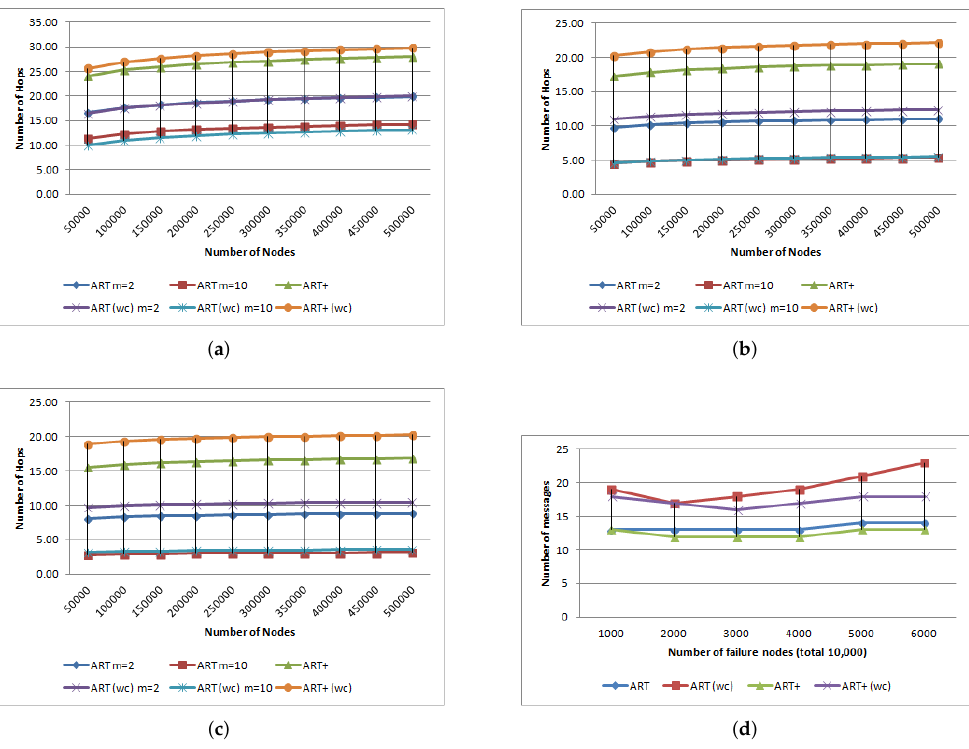
Figure 9. Cost of search operations. ( a ) Case b = 2, ( b ) case b = 4, ( c ) case b = 16, ( d ) massive